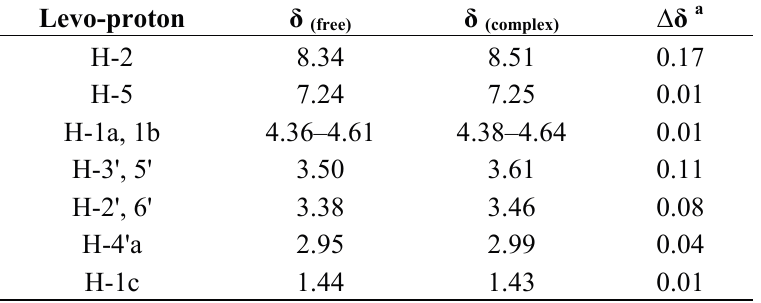
Table 5. 1 H-NMR chemical shifts of Levo and Levo + Zn 2+ (concentration ratio 1:1 at pH = 6.0).